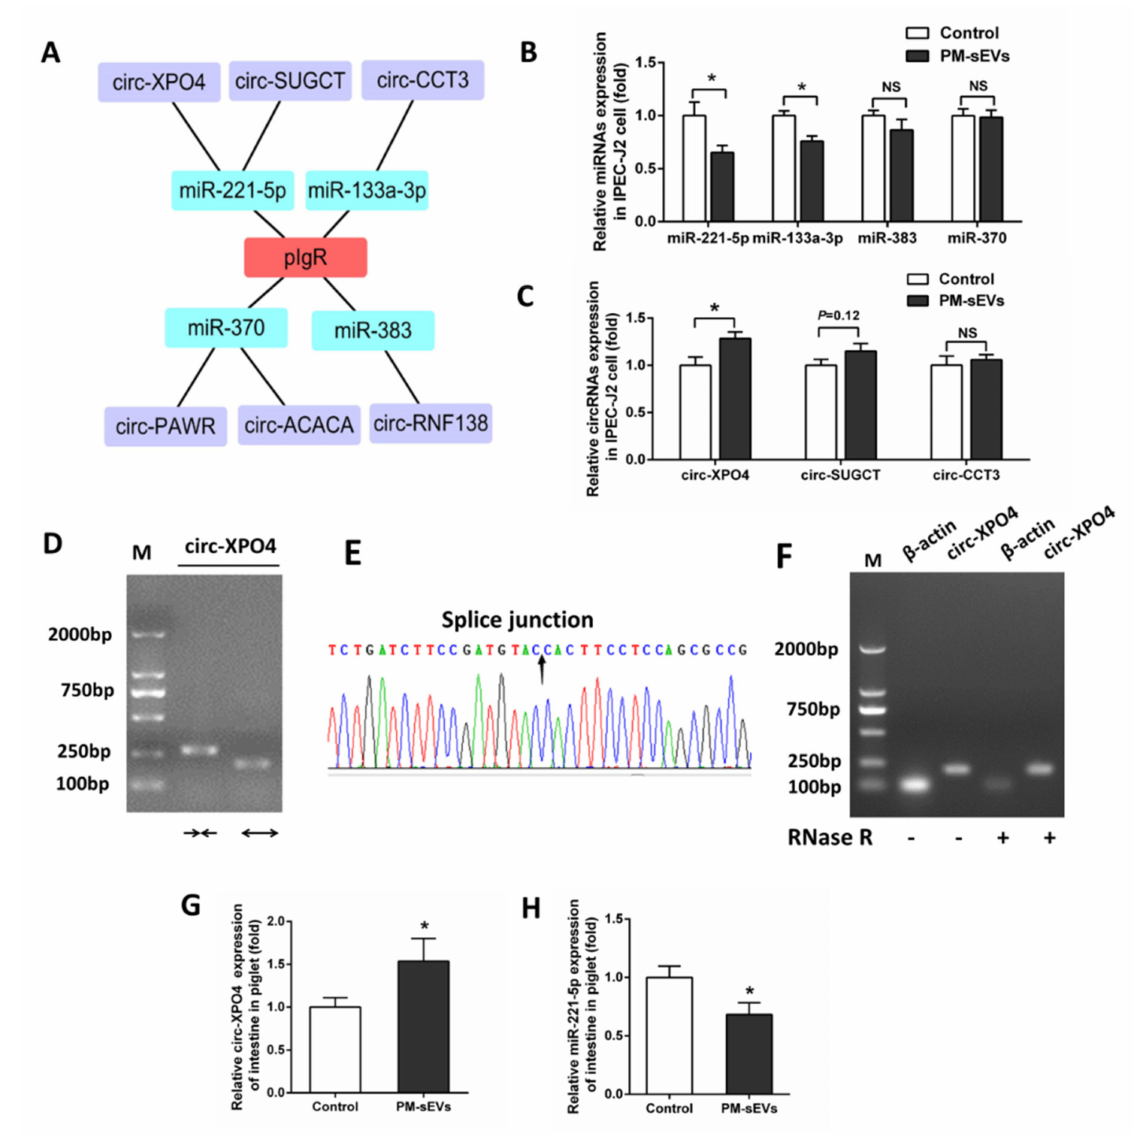
Figure 3. Effects of PM-sEVs on noncoding RNA expression in IPEC-J2 cell and piglet intestine. ( A ) The potential interaction among pIgR, miRNAs, and PM-sEVs circRNAs. ( B ) qRT-PCR analysis of miR-221-5p, miR-133a-3p, miR-383, and miR-370 expression levels in IPEC-J2 cell ( n = 6). ( C ) qRT-PCR analysis of circ-XPO4, circ-SUGCT, and circ-CTT3 expression levels in IPEC-J2 cell ( n = 6). ( D ) PCR and agarose gel electrophoresis identify PCR product size of circ-XPO4, “ →← ” represent convergent primers, “ ←→ ” represent divergent primers. ( E ) Sanger sequencing confirm the splice junctions of circ-XPO4, the arrow points to the splice junctions. ( F ) PCR and agarose gel electrophoresis analysis the abundance of circ-XPO4 and linear mRNA ( β -actin) treated with RNase R. ( G , H ) qRT-PCR analysis of circ-XPO4 and miR-221-5p expression levels in intestinal tissue of piglet ( n = 6). NS, represent non-significant ( p > 0.05); * p < 0.05. All data are presented as means ±